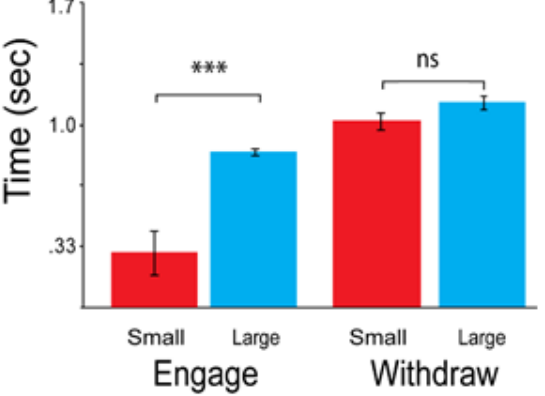
Time (Mean and Standard Error) of Engagement After Grasping for Small and Large Food Items and Total Time to Withdraw